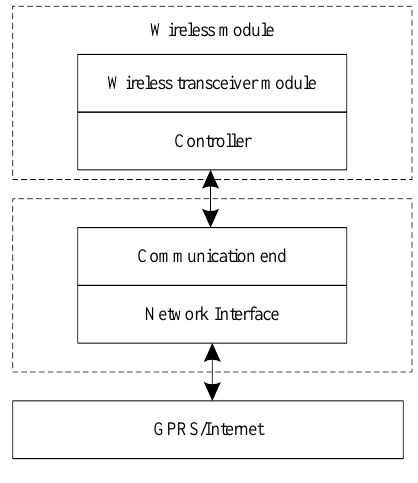
Figure 3. Main node unit structure diagram